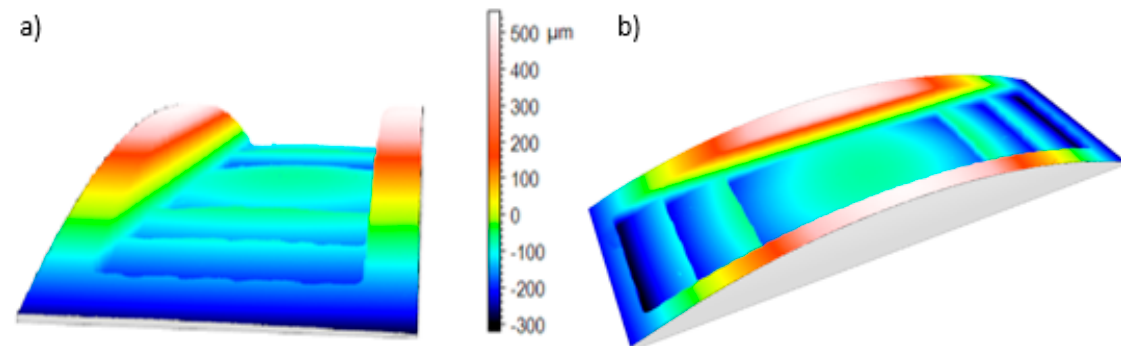
Figure 6. Laser scanning microscope image of a cavity: ( a ) view along the cavity, demonstrating the height difference of the curved surface and cavity; ( b ) three-dimensional view illustrating the flatness of the cavity.